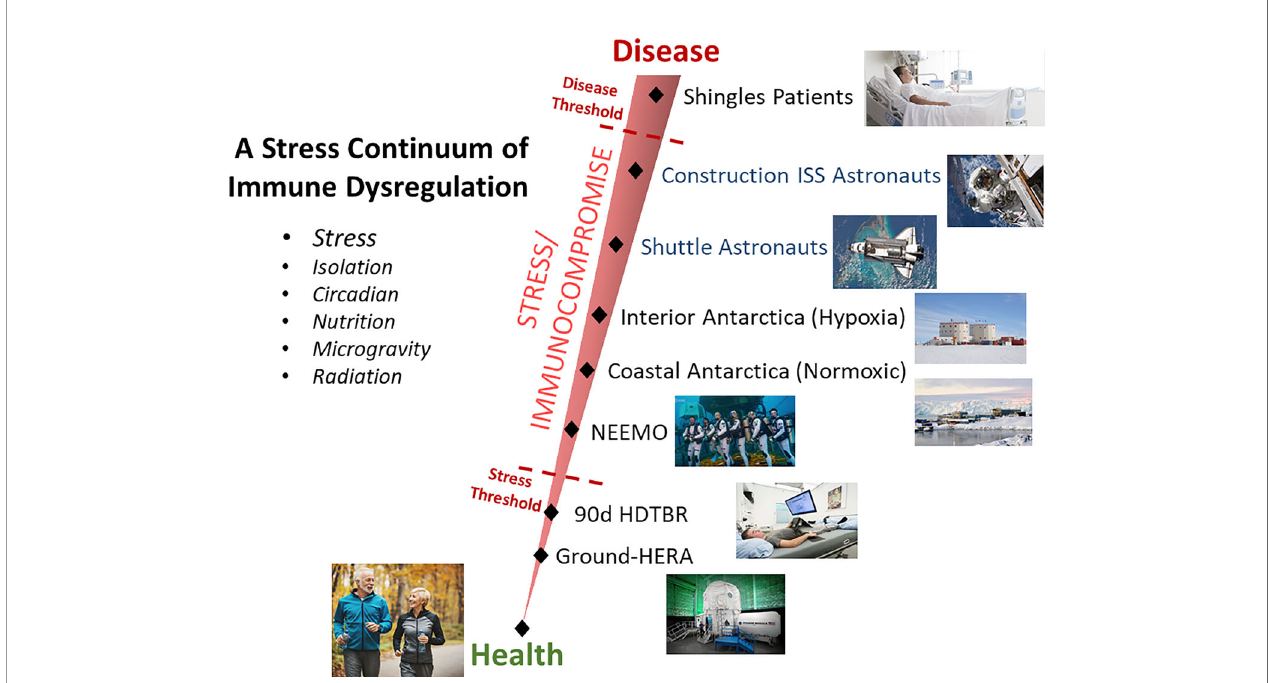
FIGURE 3 | Graphical representation of the proposed relationship between health and stress, detectable using biochemical measurements but with no clinical manifestations, and chronic stress with related adverse clinical events. Stressful conditions, such as space fl ight or various deployment ground analogs of space fl ight, are represented on the continuum based on research fi ndings. Note that current ISS astronauts general experience less stress due to certain deployed biomedical countermeasures (consequently less viral reactivation, improved cortisol levels, etc.), than astronauts during the ‘ construction phase ’ of ISS and therefore are represented lower on the stress